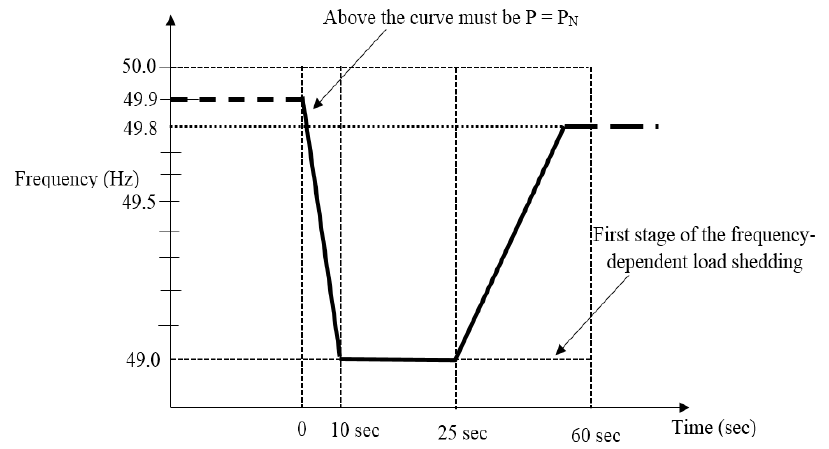
Figure 8. Stipulated grid frequency requirement as set by E.ON NETZ GmbH.